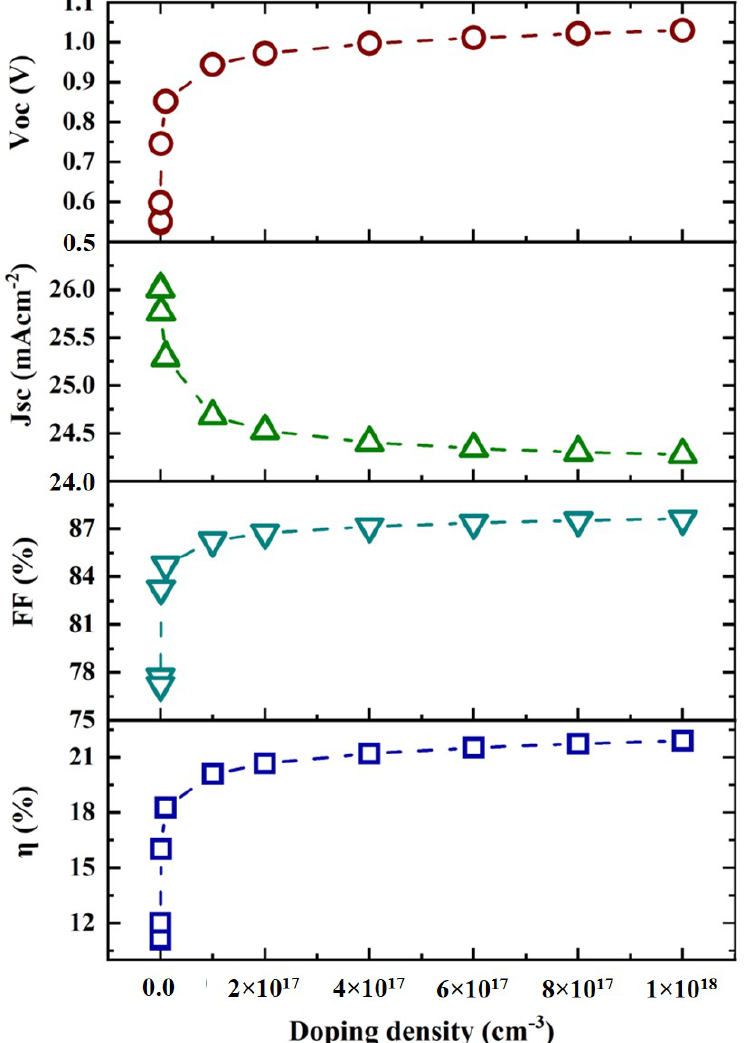
Figure 6. Doping density in the absorber layer versus V oc , J sc , FF, and η.